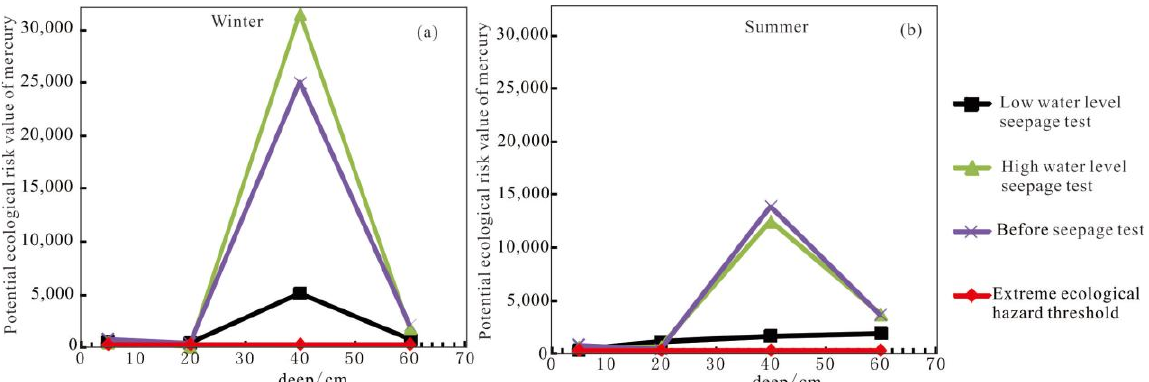
Figure 5. Line chart of potential ecological risks of mercury in the subsurface under changing river water levels. ( a )—The line chart of the ecological risk of mercury in the subsurface under the condition of changing river water level in winter; ( b )—The line chart of the ecological risk of mercury in the subsurface under the condition of changing the river water level in winter. Table 3. List of mercury speciation content and its percentage in subsurface flow zone in the dry season.